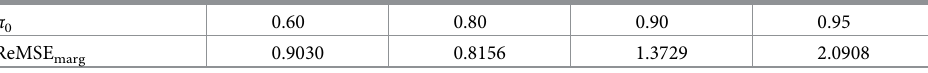
Table 1. MSE of the ARC method relative to the CRC method when there is no covariate effect. The true prior probabilities are constant, π 0 ( x i ) = π 0 . The log 2 value is given for the marginal relative MSE. Under the ARC method, Δ 0 is